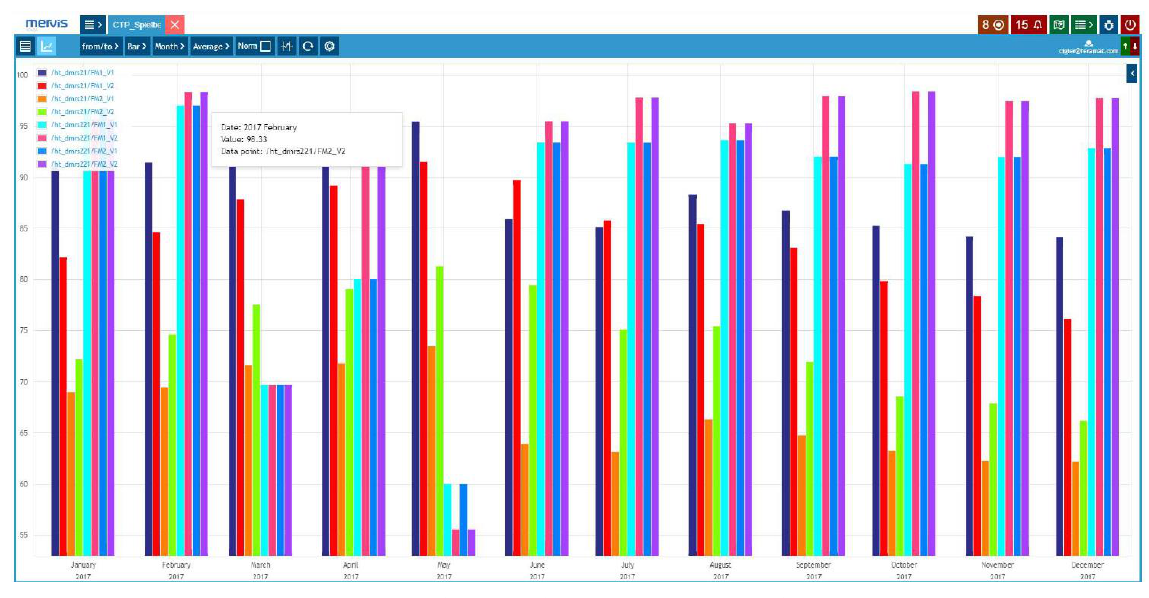
Figure 6: Average percentage of running frequency converters of air handling